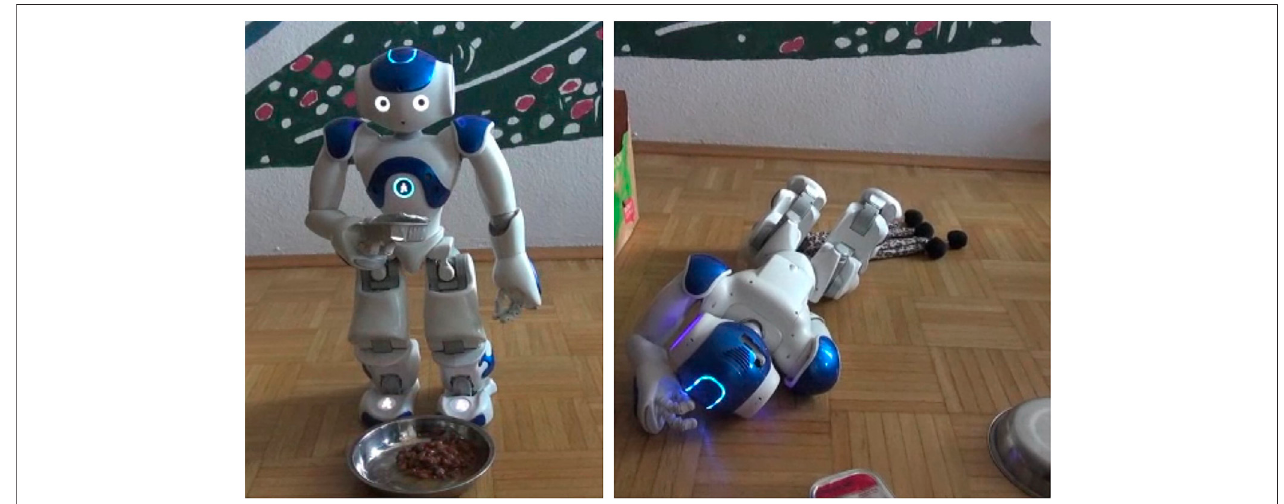
FIGURE 3 | Video stills from the positive (left) and negative (right) demonstration